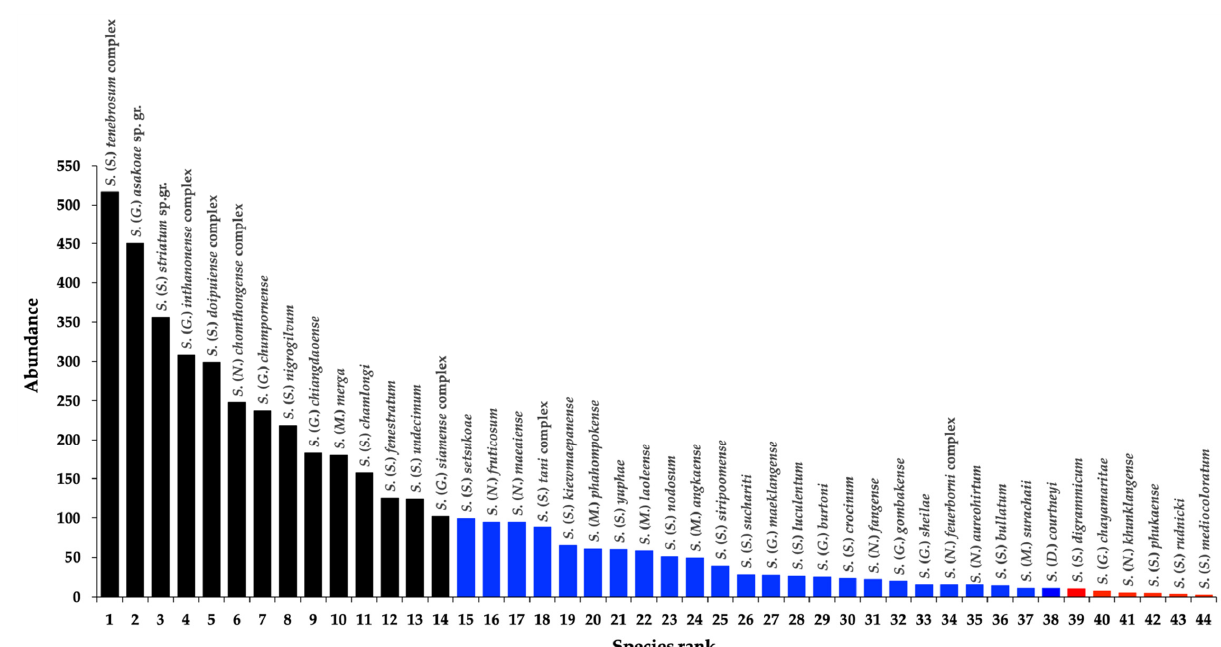
Figure 2. Abundance of black fly species distributed in Doi Inthanon National Park. Black bars represent the species found with more than 100 specimens. Blue bars represent the species found with a range of between 10 and 100 specimens. Red bars represent the species found with ≤ 10 specimens.